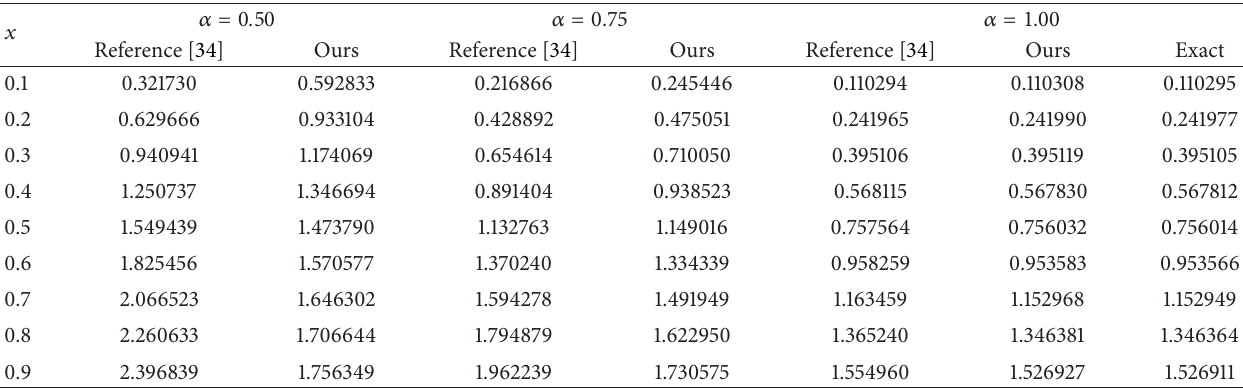
Table 2: Numerical results of Example 12 for 𝑚 = 9 in comparison to